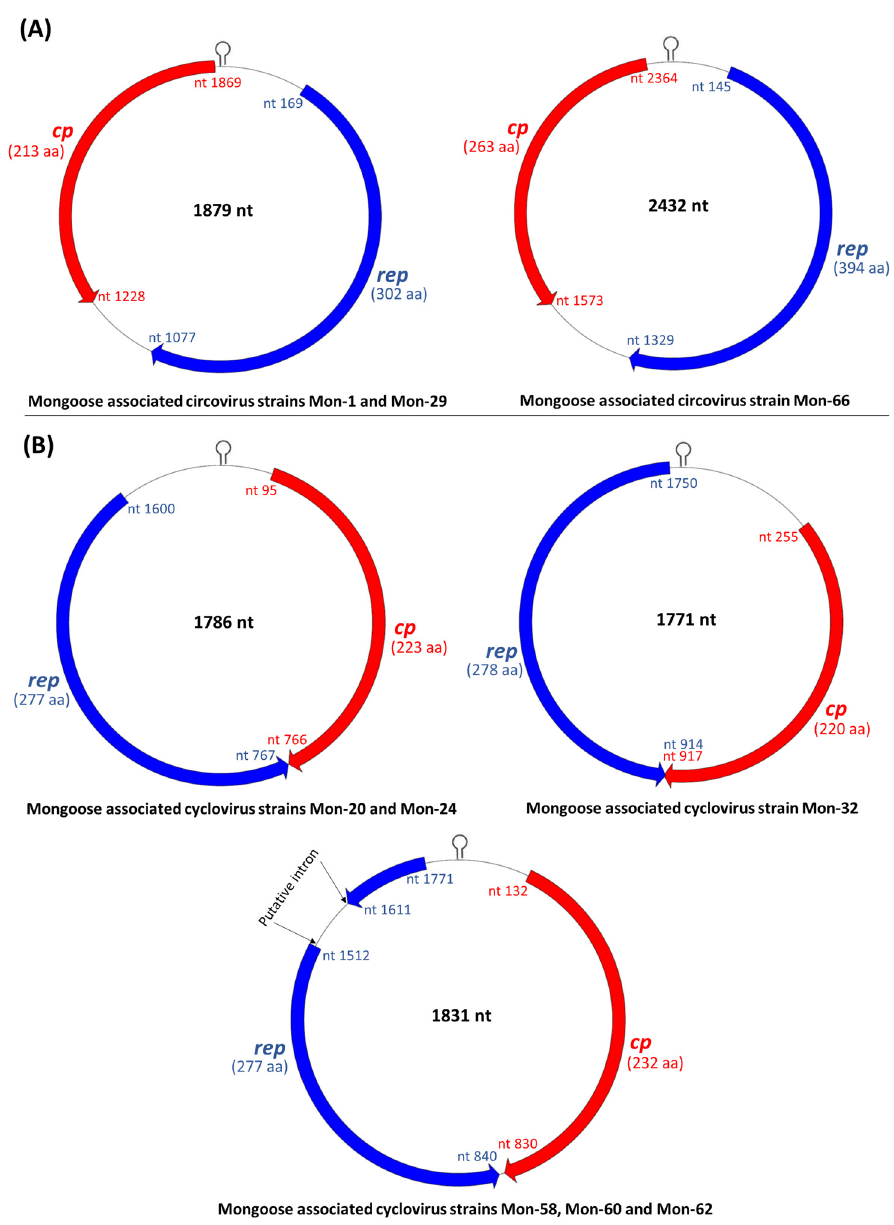
Figure 2. Genome organization of the mongoose associated circoviruses ( A ) and cycloviruses ( B ). The inversely arranged major open reading frames encoding the putative replication associated (Rep) and capsid (Cp) proteins are shown with blue and red arrows, respectively. The putative origin of replication (ori) characterized by a nonanucleotide motif at the apex of a stem-loop structure is marked in the 5 (cid:48) -intergenic region. The size of the Rep and Cp are shown in parenthesis. nt: nucleotide; aa: amino